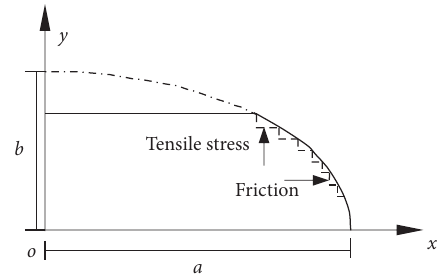
Figure 5: Lateral force area of the collapsed